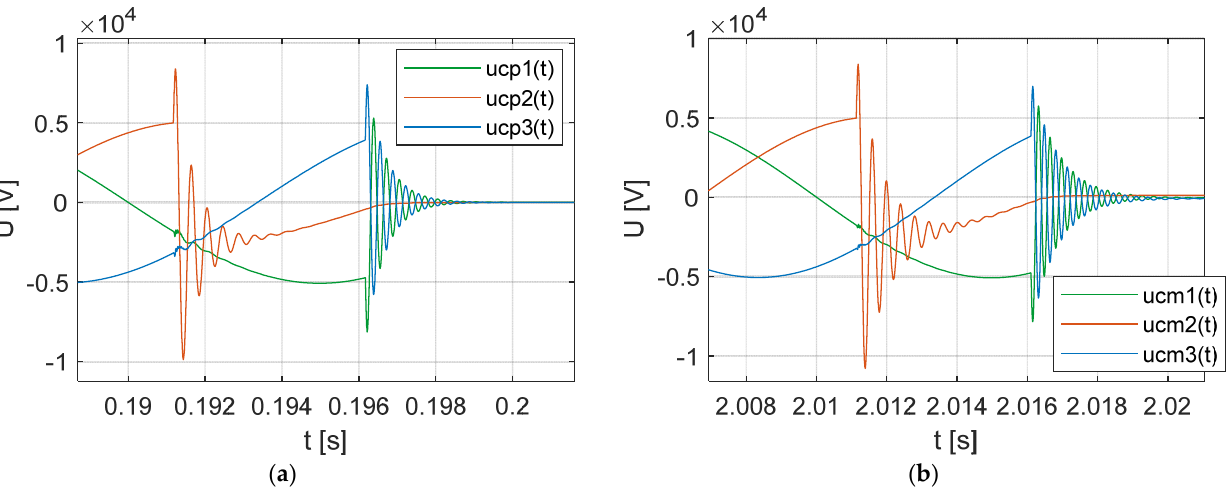
Figure 13. Simulation results— 𝑅 (cid:3008)(cid:3015) = 40 Ω ( a ) Load voltage (EMTP algorithm); ( b ) Load voltage Figure 13. Simulation results— R GN = 40 Ω ( a ) Load voltage (EMTP algorithm); ( b ) Load voltage (Clark transformation). Source: own calculations. (Clark transformation). Source: own calculations.